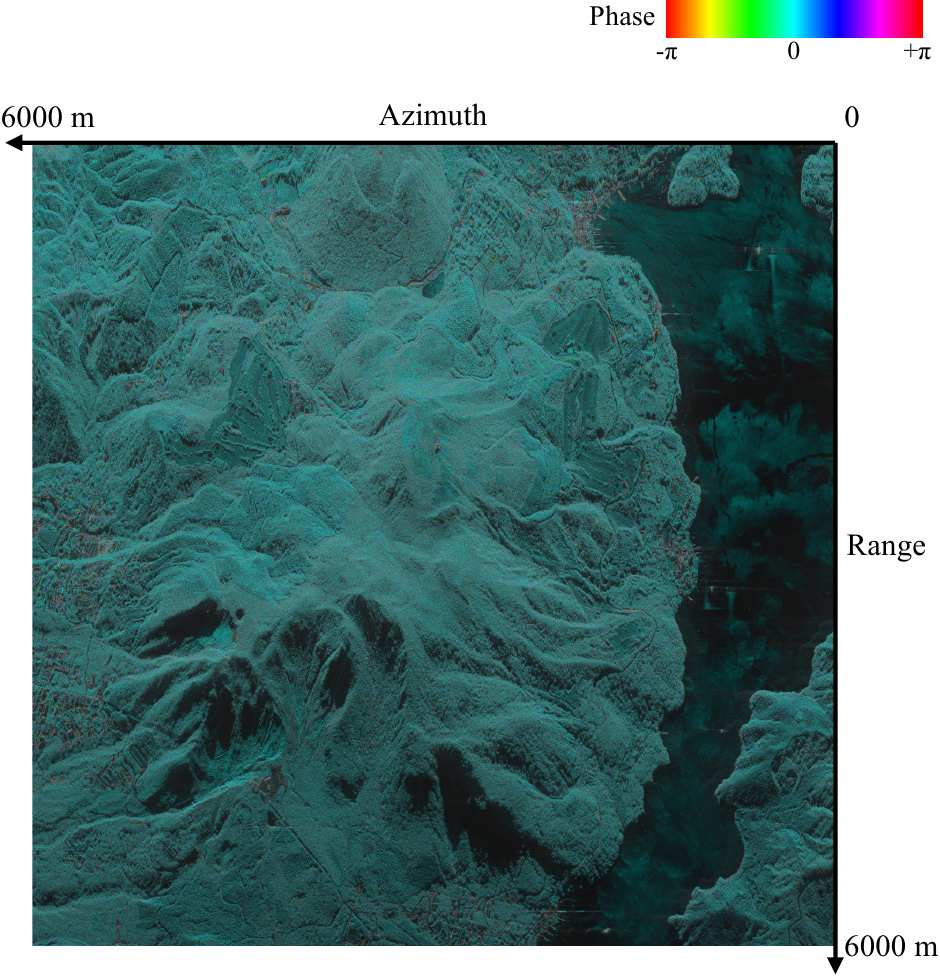
Figure 8. MGP_C_VVm image around Mount Hakone on 3 December 2015 (Center: N35.218,